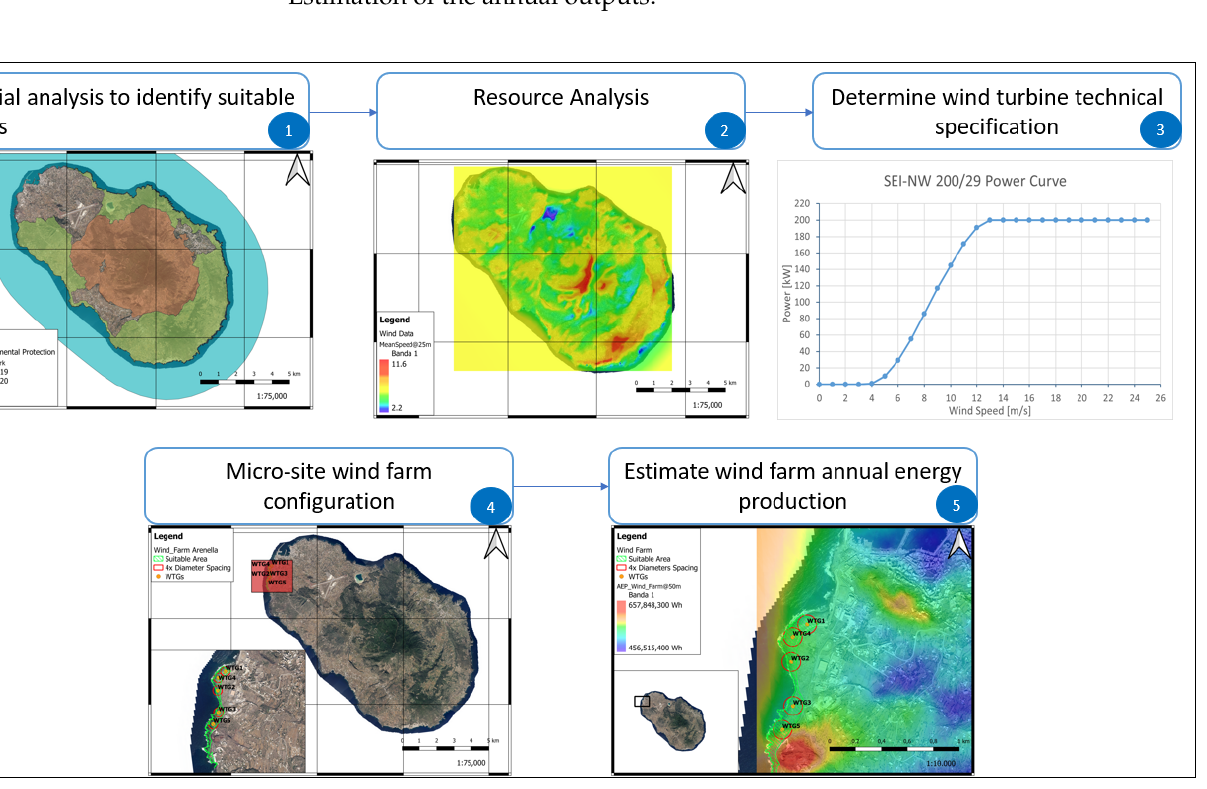
Figure 8. Wind technical potential